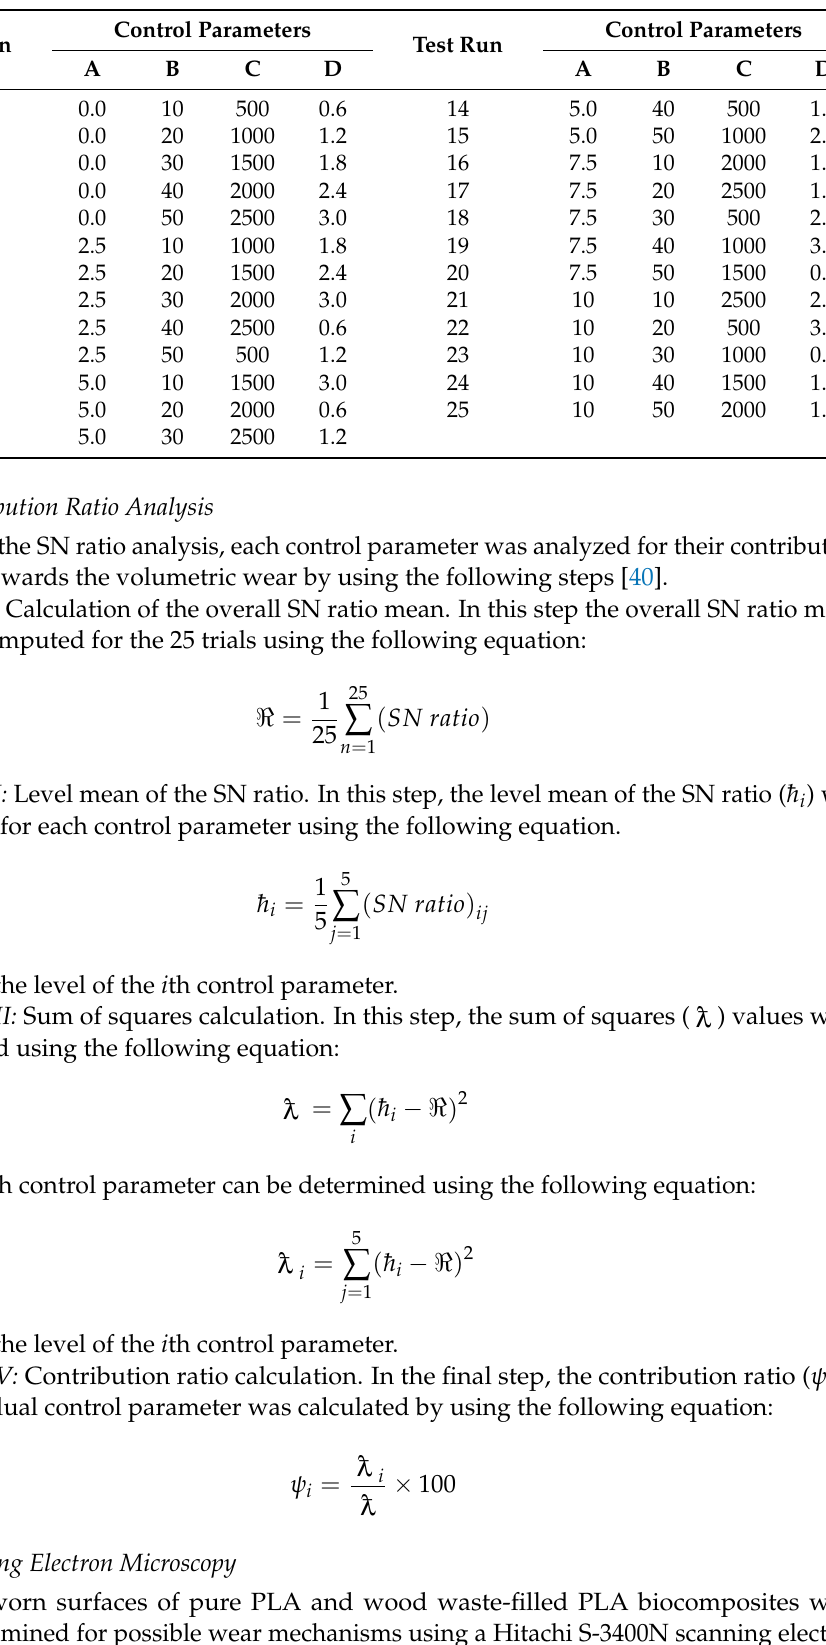
Table 2. Experimental design. where y = volumetric wear and n = number of trials. Control Parameters Test Run